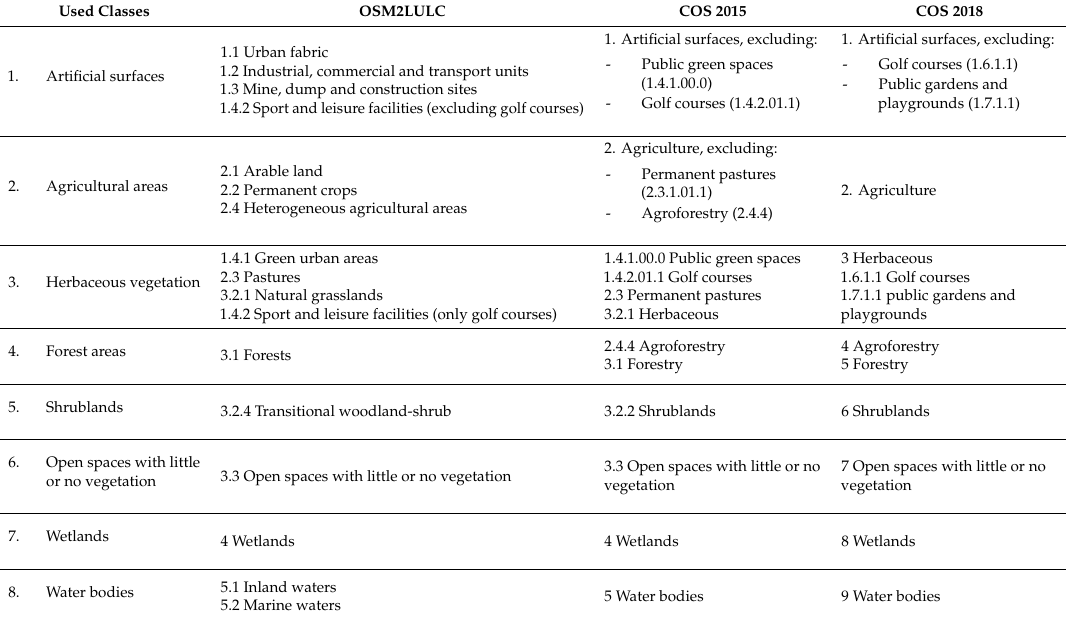
Table 4. Harmonization of the nomenclatures of the used data sources.